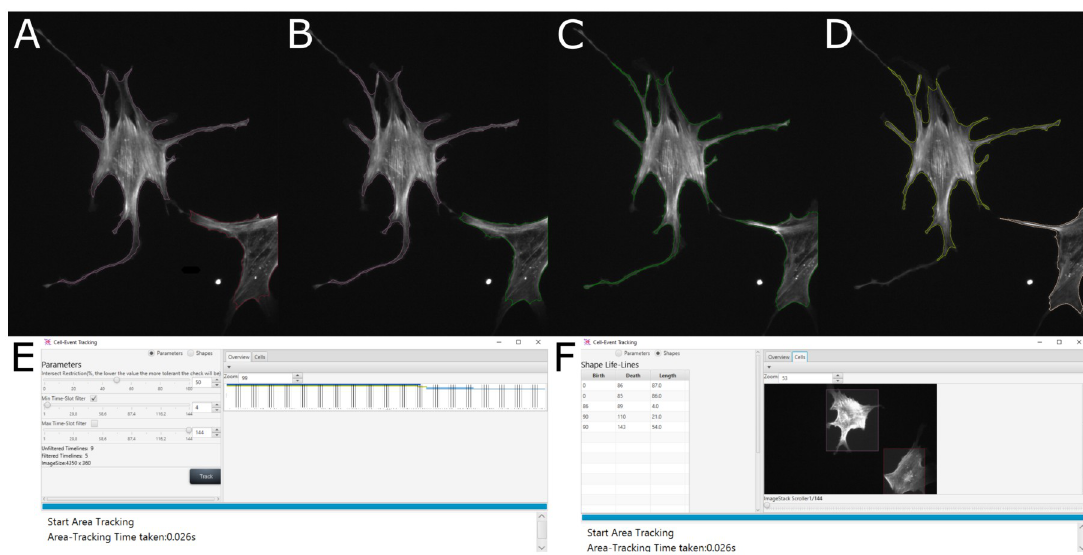
Fig 5. Bounding box feature for cell event detection. Example visualization of cell events as they appear in the GUI: A : Initial images, two cells recognized. B : Color of right cell changed due to edge touching. C : Cell contact detected based on area outline of both cells, cells appear in same color. Note that the shown area outline does not stretch to the cell extension that is responsible for the ‘contact’ flag, as the area output of the FS2.0 is more filtered than the stage used for the bounding box feature. D : Cells de-touched again, both cells are assigned new lifelines and new colors. E : Bounding box feature window with filter options and lifelines found visible. F : Bounding box feature window with marked cells and cell lifeline information